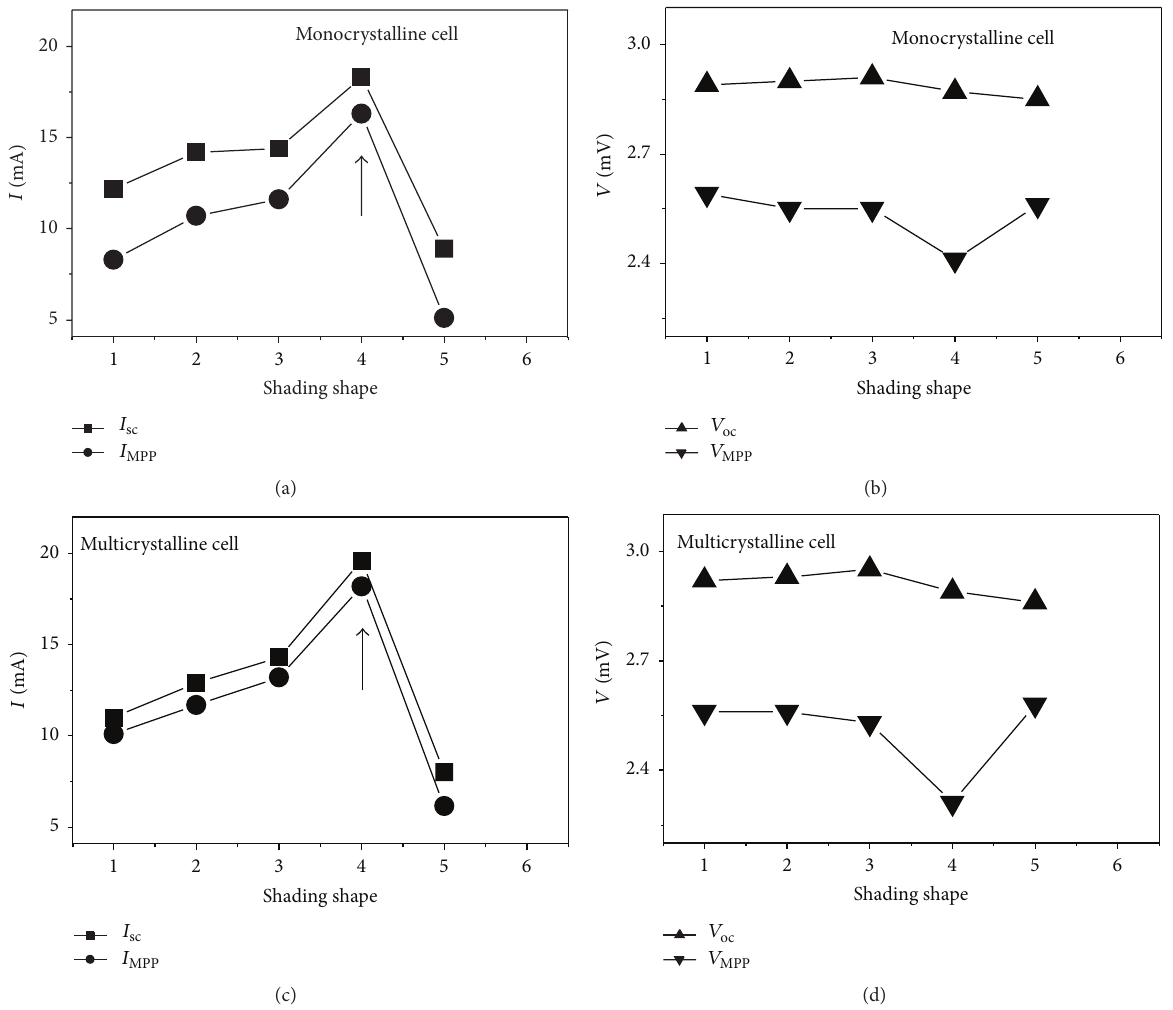
Figure 4: 𝐼 sc , 𝐼 MPP , 𝑉 oc , and 𝑉 MPP of monocrystalline ((a) and (b)) and multicrystalline ((c) and (d)) silicon solar cells against center shelters with isosceles triangle, circle, square, and two rectangles black